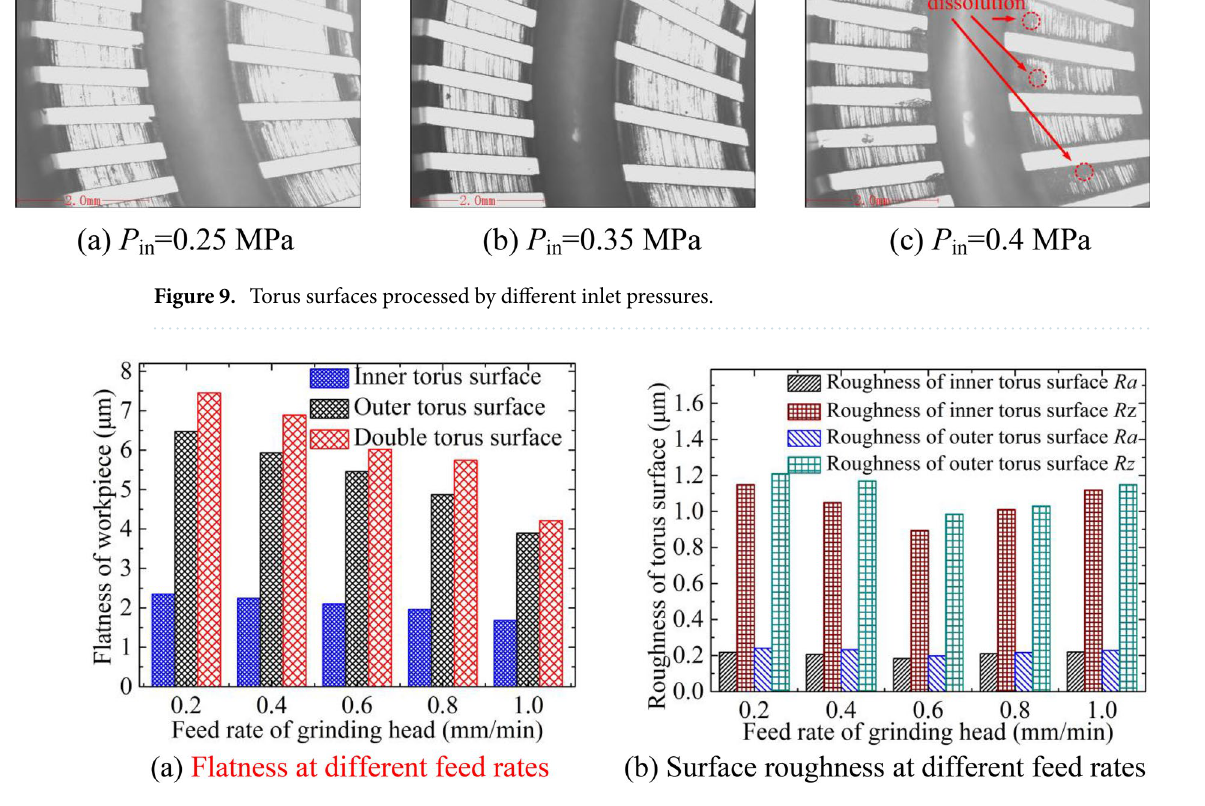
Figure 10. Flatness and roughness at different feed